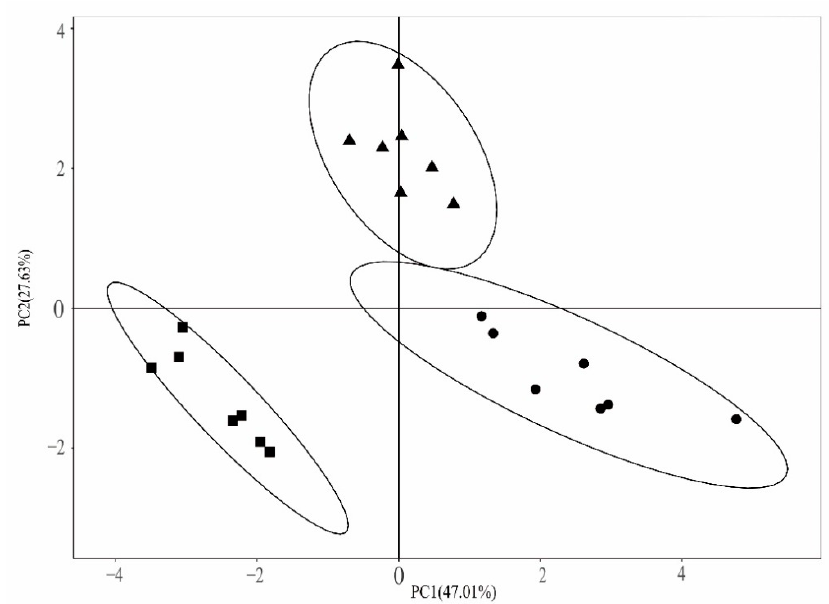
Figure 6. Soil PLFAs under different atrazine application treatments. Data represent the mean ± SD of each soil sample selected at each time-point. ( A ) Gram-positive bacterium (G+); ( B ) Gram-negative bacterium (G-); ( C ) bacterial; ( D ) fungal.